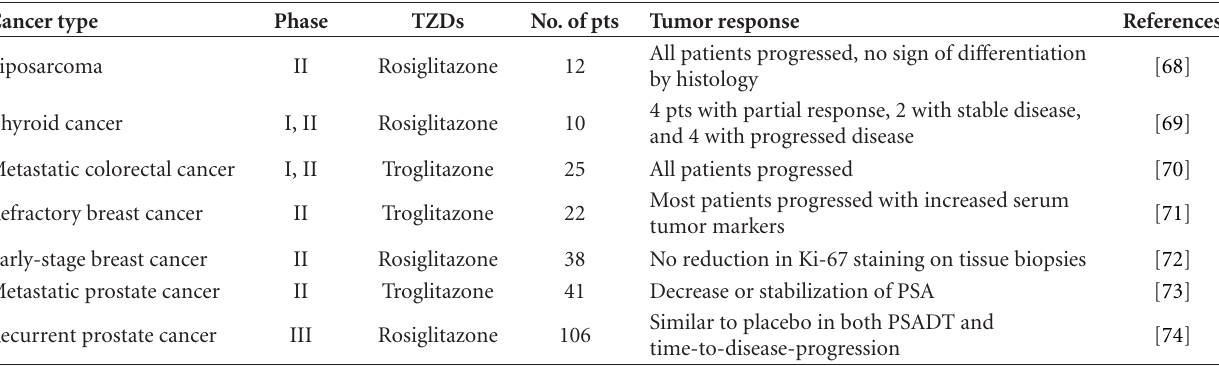
Table 7: Clinical trials of TZDs in cancer